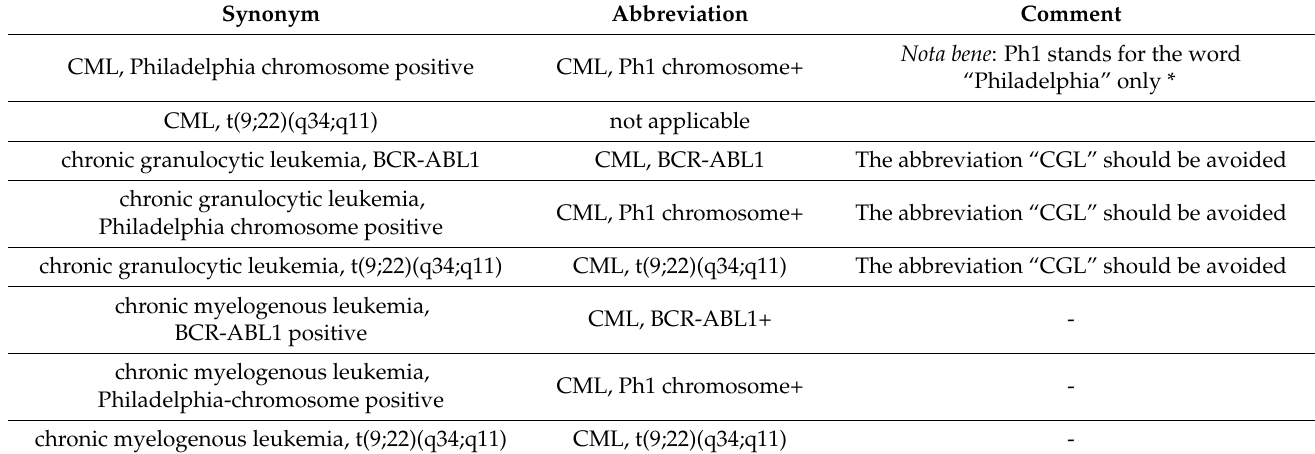
Table 1. Synonyms of chronic myeloid leukemia (CML), BCR-ABL1 positive.